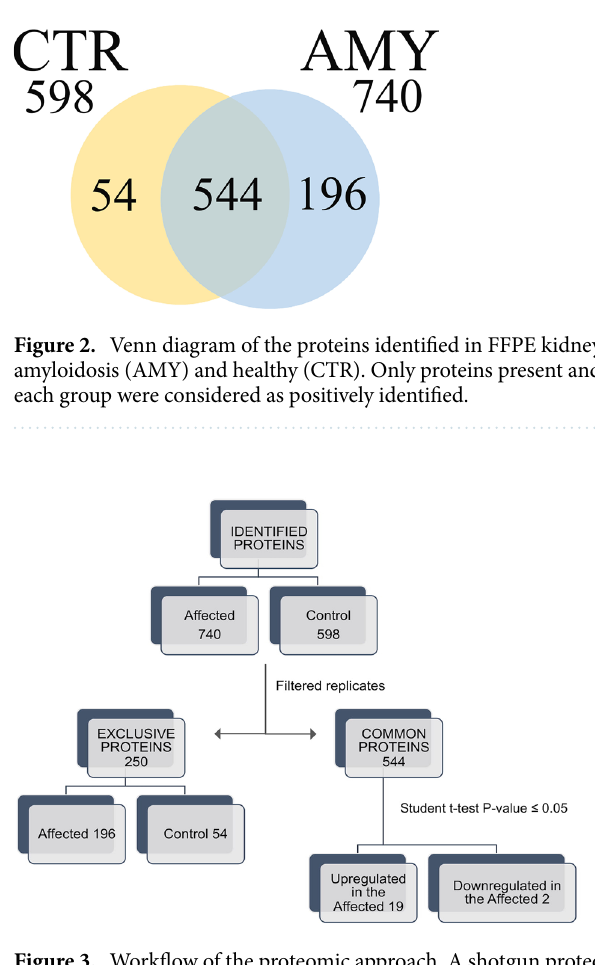
Figure 3. Workflow of the proteomic approach. A shotgun proteomic analysis was performed on FFPE kidney tissue from cats affected by renal amyloidosis (Affected) and healthy (Control). Statistical analyses were performed using the Perseus software (version 1.4.0.8, www. bioch em. mpg. de/ mann/